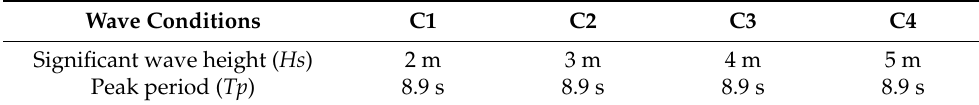
Table 7. Typical wave conditions under different wave